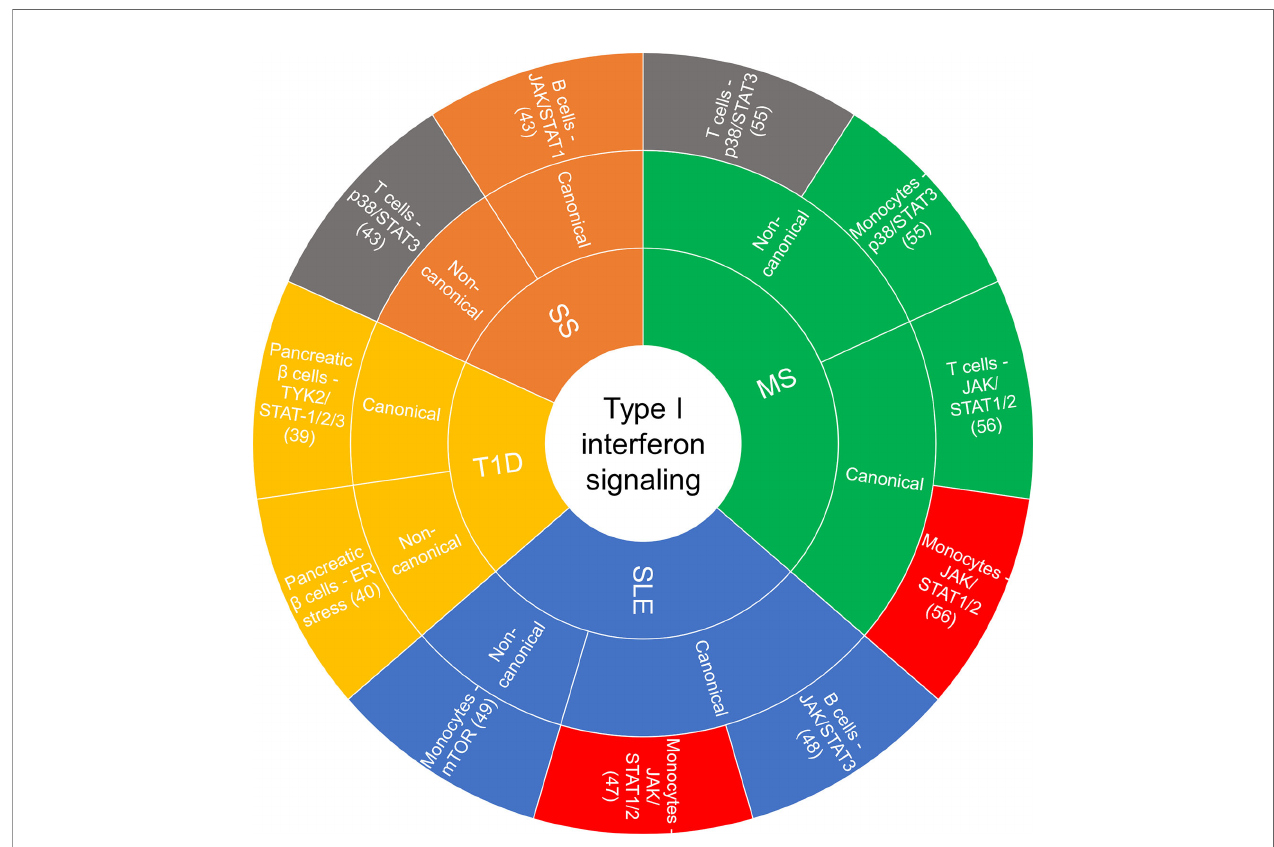
FIGURE 2 | Sunburst chart of cell-speci fi c canonical and non-canonical signaling recently reported on in autoimmune diseases. If there was a commonality in a canonical or non-canonical signaling demonstrated in the same cell type but different disease, they were color coded the same: red — JAK/STAT1/2 in monocytes, gray — p38/STAT3 in T cells. ER, endoplasmic reticulum; JAK, janus kinase; MS, multiple sclerosis; mTOR, mammalian target of rapamycin; SLE, systemic lupus erythematosus; SS, Sjögren ’ s syndrome; STAT, signal transducer and activator of transcription; T1D, type I